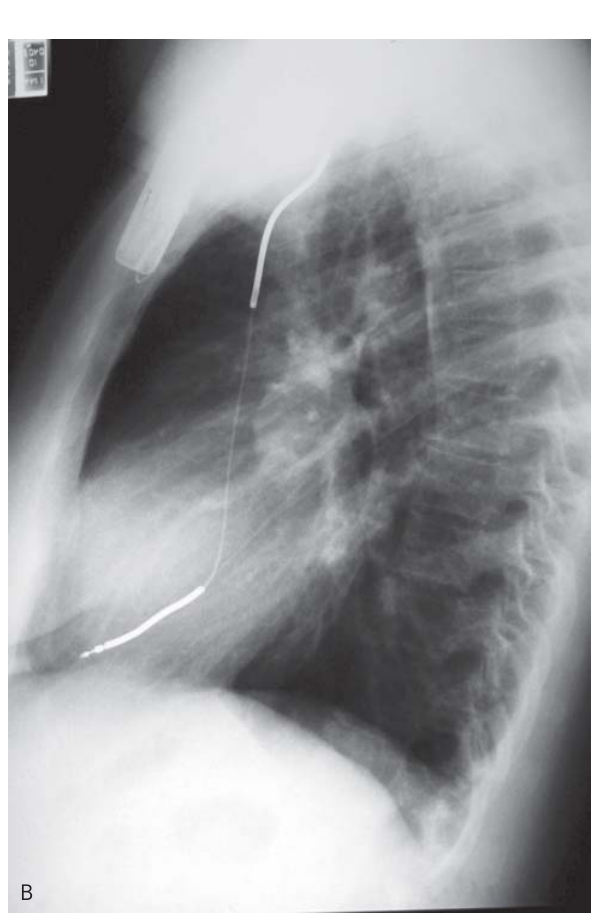
Fig. 1 – A: Radiografia torácica em posição póstero-anterior (A) e perfil (B), demonstrando a posição dos cabos-eletrodos do CDI implantado pela veia cefálica